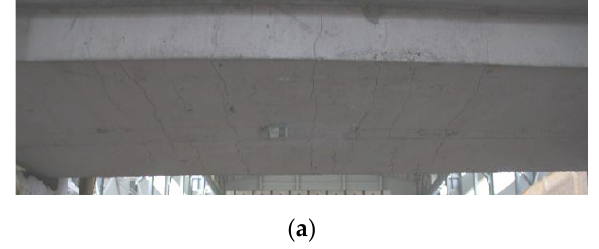
Figure 10. Cracks in the mid-span. ( a ) Beam 1; ( b ) 1/4-span of Beam 3.